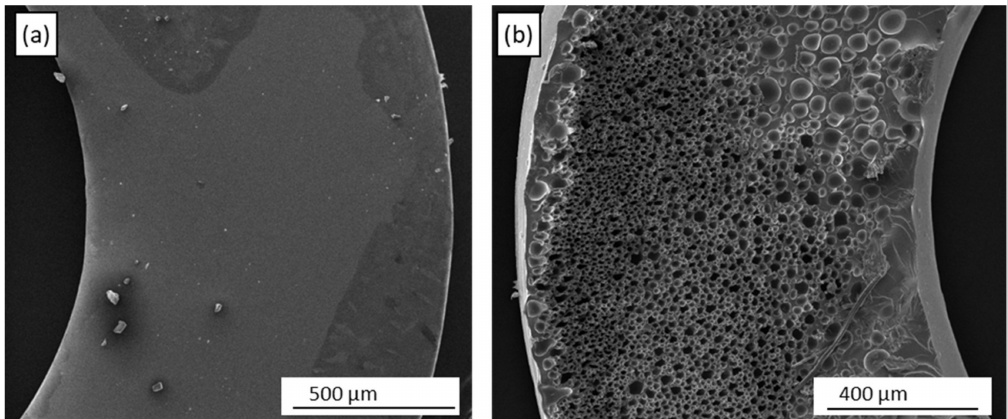
Figure 12. Scanning electron microscopy (SEM) images of front ( a ) and back ( b ) surfaces of SiCNO ceramics formed by pyrolysis of laser crosslinked Ceraset. The microporosity in ( b ) stems from oleic acid, which was used to prevent adhesion during laser